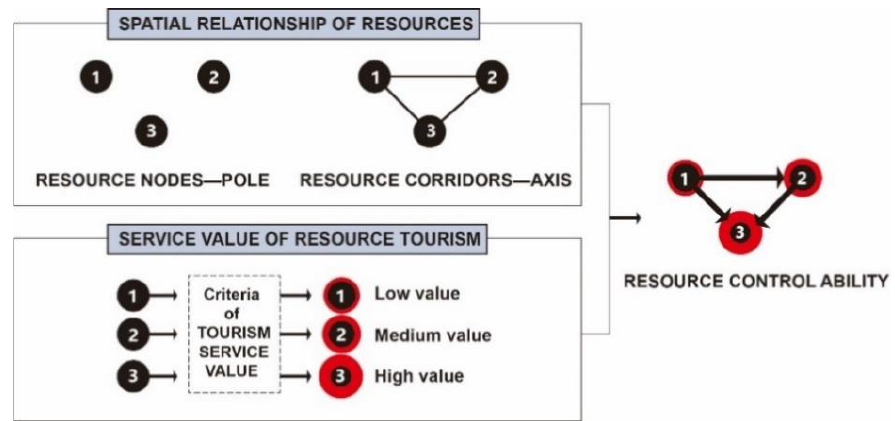
Figure 2. Analysis path of the tourism network structure.